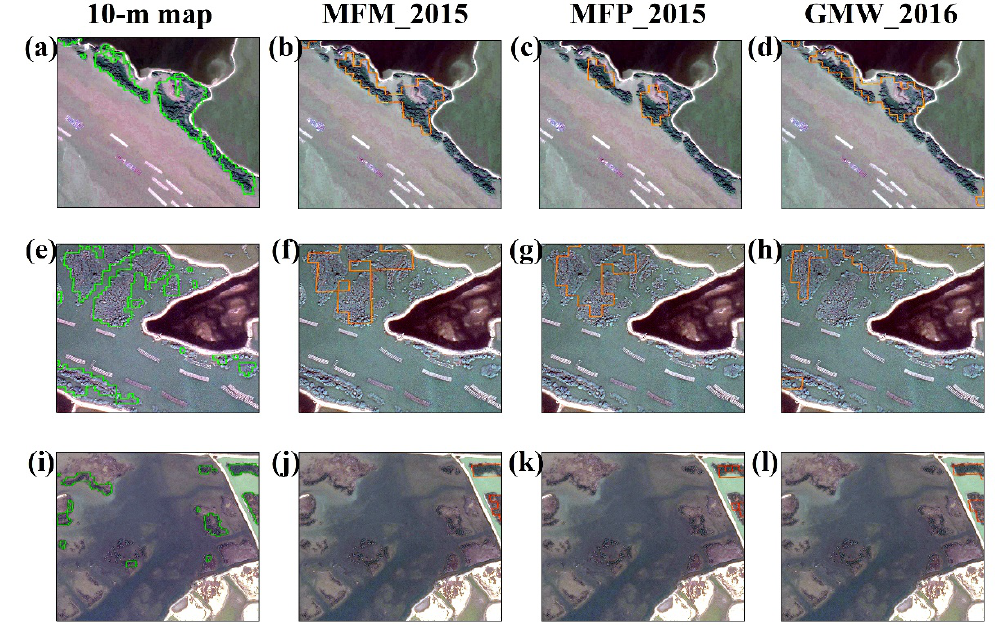
Figure 9. A comparison of mangrove extraction results derived from our 10-m map and 30-m products in the Zhanjiang region, Guangdong province, where mangrove area differences for all 30-m products are larger than 100 ha. The green and orange color represents the boundary of the 10-m and 30-m mangrove map. ( a )–( d ) are comparison results for a subset dominated by mangroves in narrow strips; ( e )–( h ) are comparison results for a subset dominated by sparse mangroves; ( i )–( l ) are comparison results for a subset dominated by mangroves with small patches.